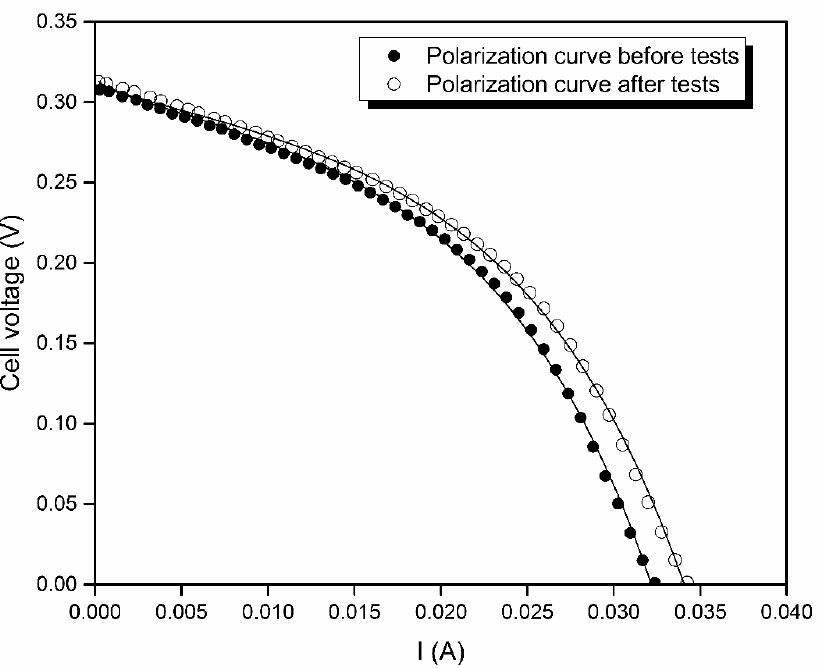
Figure 6. Fitting results of the polarization curves obtained before and after the flow rate tests.